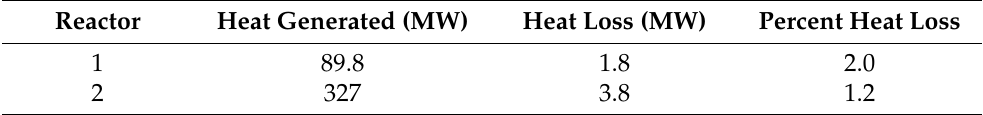
Table 12. Heat generated from the combustion of natural gas, heat loss from the walls, and percentage heat